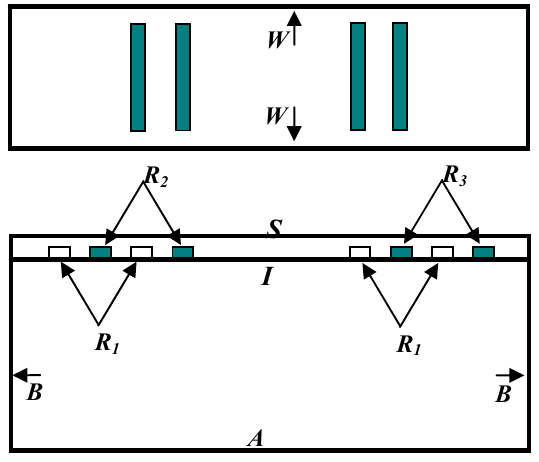
Figure 4. Boundary condition representation.